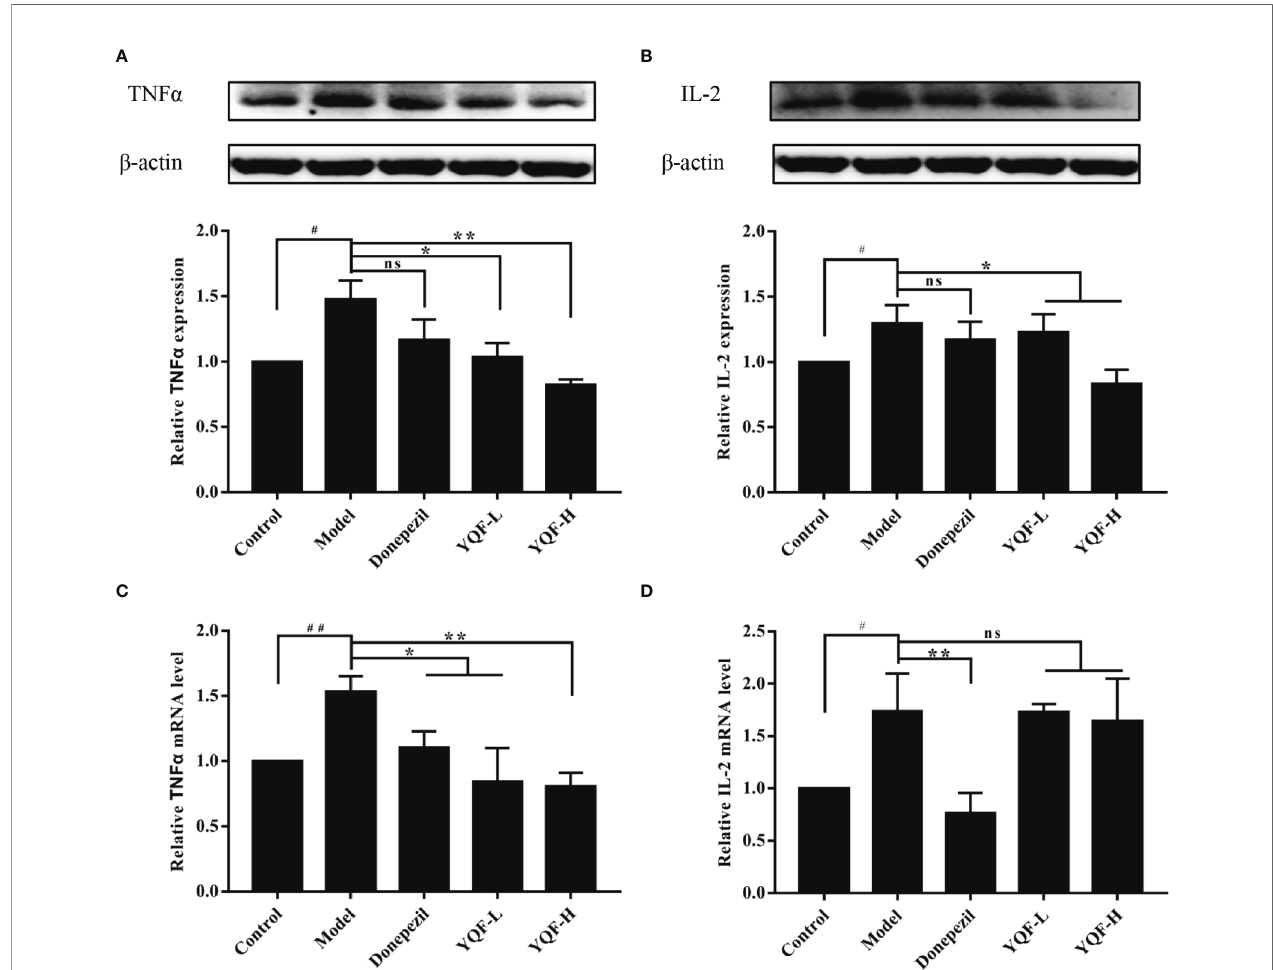
FIGURE 6 | Effect of YQF extract on the expression of TNF a and IL-2. (A) YQF extract suppressed TNF a expression. (B) YQF extract decreased IL-2 expression. (C) Quantitative analysis of TNF a mRNA by RT-PCR. (D) Quantitative analysis of IL-2 mRNA by RT-PCR. The results were obtained from three independent experiments. The data are expressed as mean ± SEM, n = 4. # p < 0.05, ## p < 0.01, compared with control group; * p < 0.05, ** p < 0.01, compared with Model group. ns, no signi fi cant